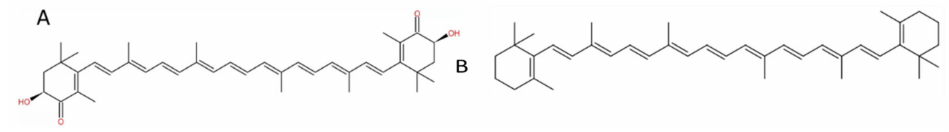
Figure 2. Chemical structure of ASX ( A ) and β -carotene ( B ) (created with KingDraw http://www. kingdraw.cn/en/index.html , accessed on 2 February